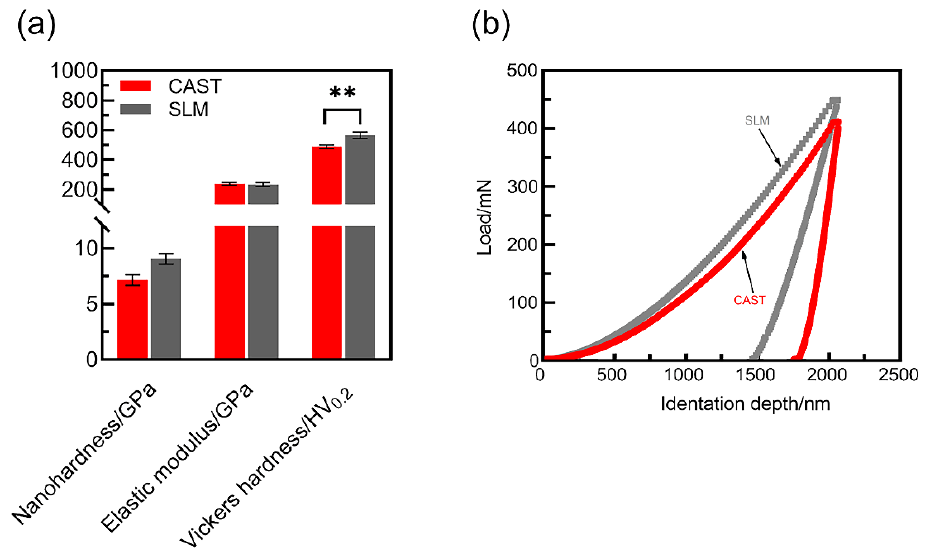
Figure 5. Mechanical properties of the Co-Cr alloys: ( a ) Nanohardness, elastic modulus and Vickers hardness; ( b ) Load–displacement curves (** p < 0.01).